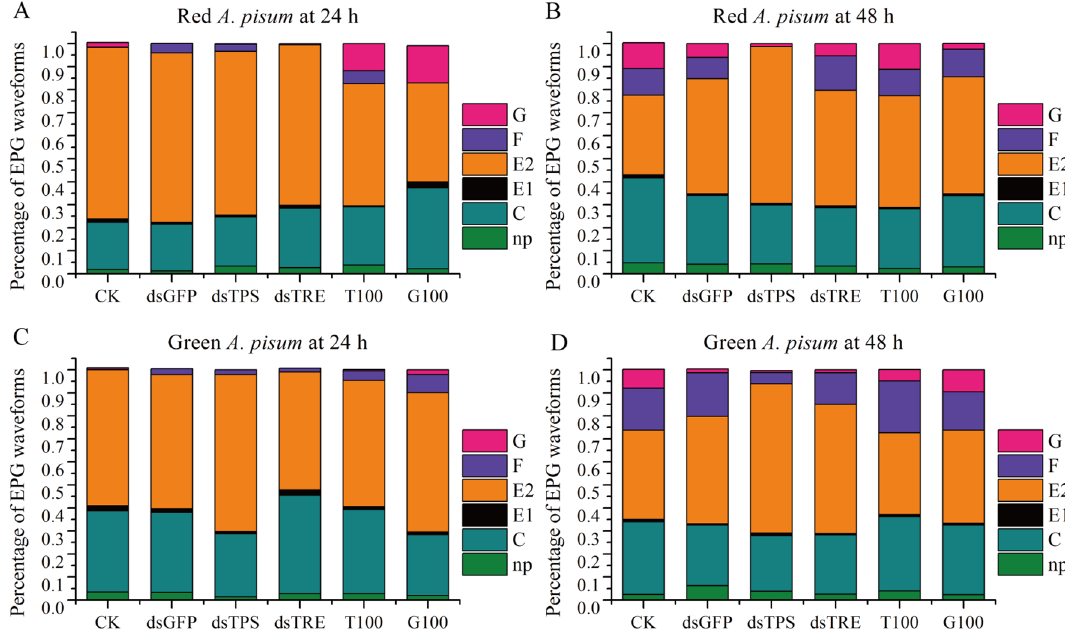
Figure 3. Mean percentage of the EPG waveforms during 8 h EPG recording. The percentages of EPG waveforms in red A. pisum biotype at 24 h and 48 h were resented in ( A and B ), repectively. The percentages of EPG waveforms in green A. pisum at 24 h and 48 h were resented in ( C and D ), respectively. dsGFP: A. pisum treated with RNAi of GFP , dsTPS: A. pisum treated with RNAi of TPS , dsTRE: A. pisum treated with RNAi of TRE , T100: A. pisum treated with high trehalose diet, G100: A. pisum treated with high glucose diet, CK: A. pisum fed with normal diet. The waveform for xylem ingestion (G), waveform for derailed stylet mechanics (F), waveform for phloem ingestion (E2), waveform for phloem salivation (E1), waveform for intercellular apoplastic stylet pathway (C) and non-probing (np) are present in different colours. Edited in Origin version 8.5 (https:// www. origi nlab.